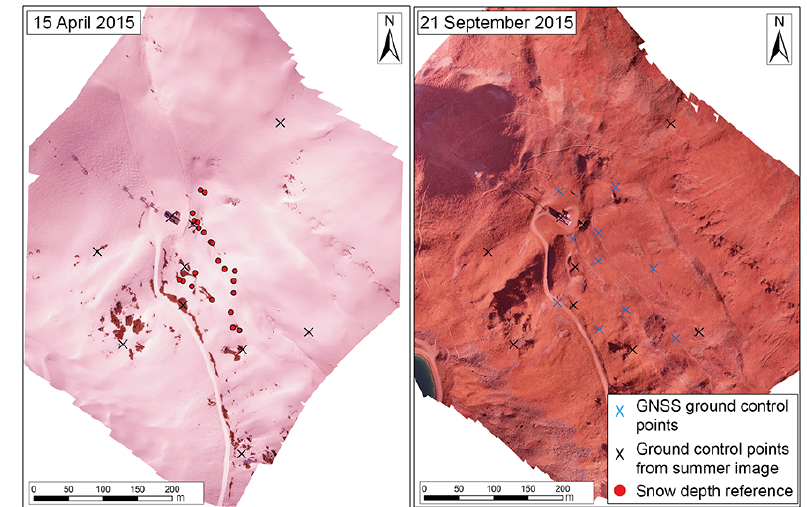
Figure 3. Near-infrared orthophotos snow-covered (left panel) and snow-free (right panel), acquired over the Brämabühl test site including the applied reference points and reference HS